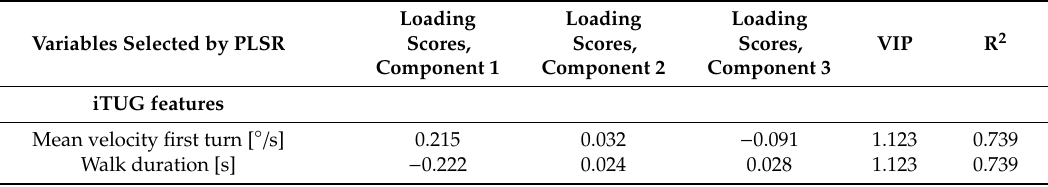
Table 2. Loading scores, regression coe ffi cient (R 2 ) and variable importance in projection (VIP) scores for all variables selected, and R 2 of the first three components in the PLSR analysis for iTUG features and descriptive